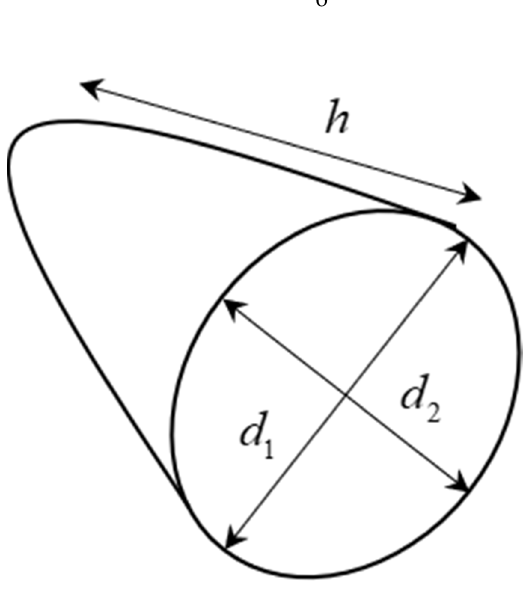
Figure 6. Example of the top and base part of an elliptical vegetable or fruit.